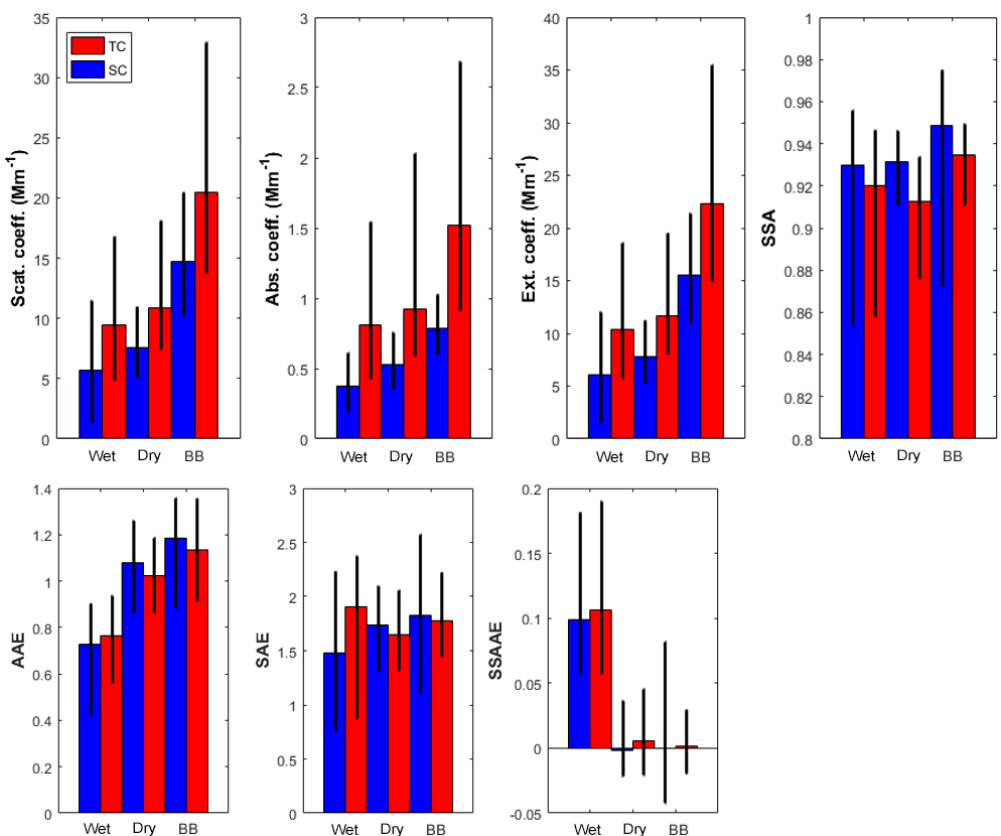
Figure 7. Median aerosol particle optical properties at 500nm for each season and each atmospheric layer determined by the method detailed in Sect. 2.3. Red bars represent the turbulent-condition optical properties and blue bars the stable-condition properties. Error bars correspond to the 25th and 75th